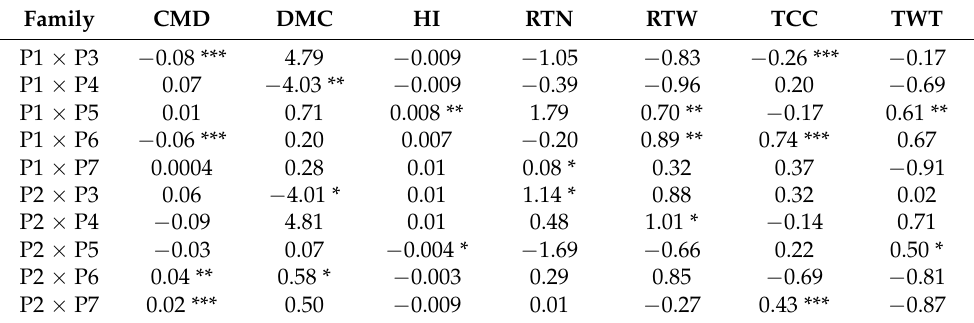
Table 5. Specific combining ability effects of parents for seven traits evaluated across two locations in